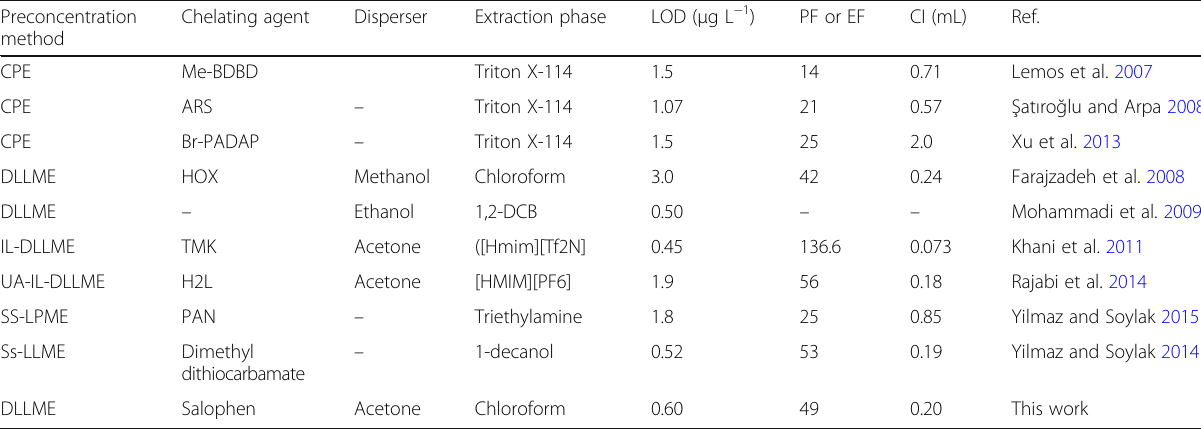
Table 7 Comparison between the developed method and some preconcentration methods combined with flame atomic absorption